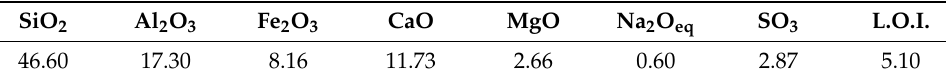
Table 1. Chemical analysis of fly ash (wt%).